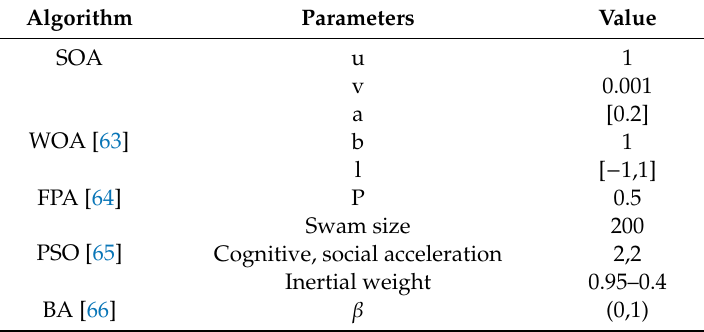
Table 1. Parameters and references of the comparison algorithms.